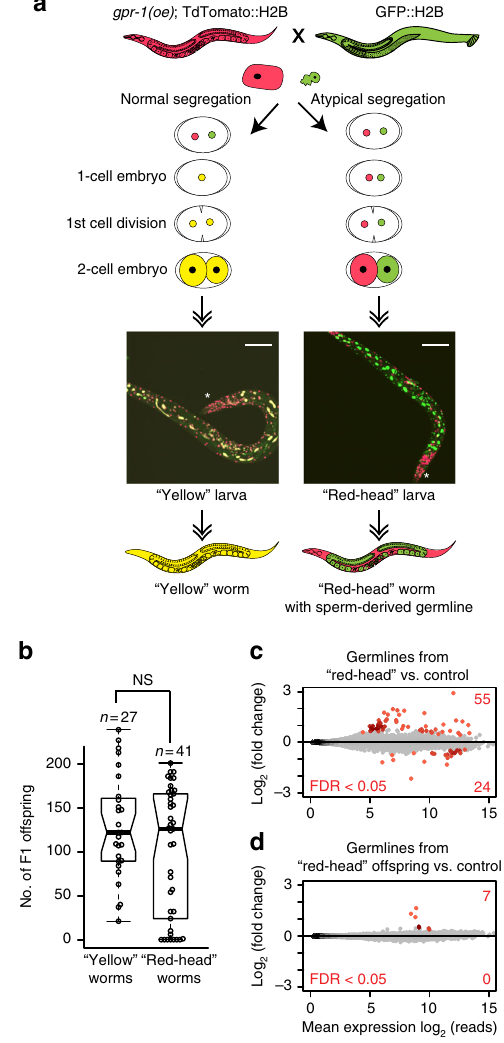
Fig. 5 The sperm epigenome is suf fi cient for germline development in offspring. a Genetic strategy to test if sperm chromatin marking is suf fi cient for germ cell development in offspring, using a worm strain that produces some normal-segregation embryos in which each cell inherits both maternal and paternal chromosomes (schematically shown as yellow nuclei) and some atypical-segregation embryos in which the 2 cells of 2-cell embryos inherit either maternal or paternal chromosomes (schematically shown as red and green nuclei). Normal-segregation embryos develop into “ yellow ” worms. Atypical-segregation embryos develop into “ red-head ” worms (* marks the head). In “ red-head ” worms, the germline contains only sperm-derived chromosomes. Scale bars represent 100 μ m. b Brood size analysis of “ yellow ” (normal segregation) vs. “ red-head ” (atypical segregation) F1 offspring, NS (not signi fi cant), p = 0.27 Mann – Whitney ’ s test. Data from 7 experiments are shown. Each box extends from the 25th to the 75th percentile, with the median indicated by the horizontal line; whiskers extend from the 2.5th to the 97.5th percentile. c Differential gene expression analysis (MA plot) of germlines from the “ red-head ” F1 hermaphrodites (germlines derived solely from sperm chromosomes) vs. GFP::H2B control hermaphrodites (genetically identical control germlines, but derived from both maternal and paternal chromosomes) (top) and their F2 offspring (bottom). Two biological replicates were obtained for each sample. Signi fi cantly misregulated genes (FDR < 0.05) were calculated with DESeq2 and are shown in red, and the total numbers of up- and downregulated genes are displayed in the right